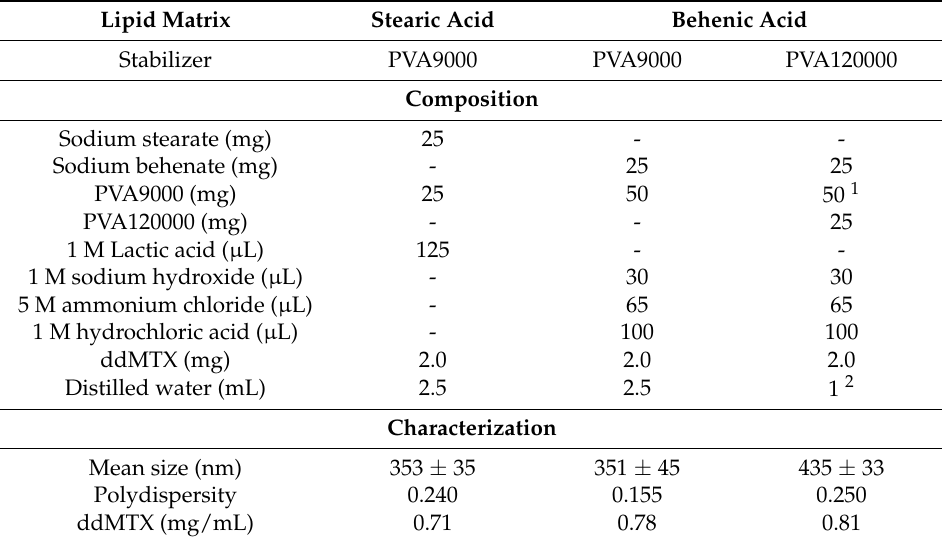
Table 1. Composition and characterization of the unfunctionalized ddMTX-loaded SLNs. Lipid Matrix Stearic Acid